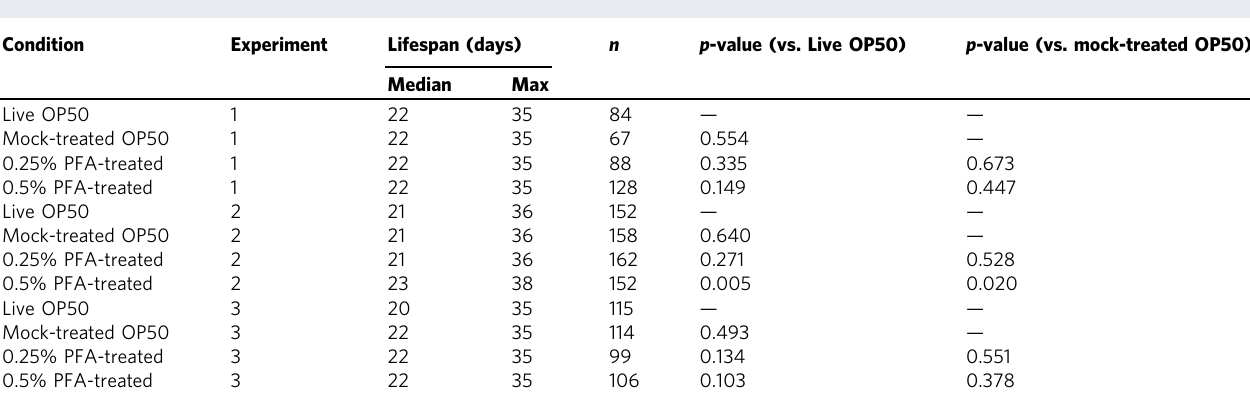
Table 2 Summary of lifespan